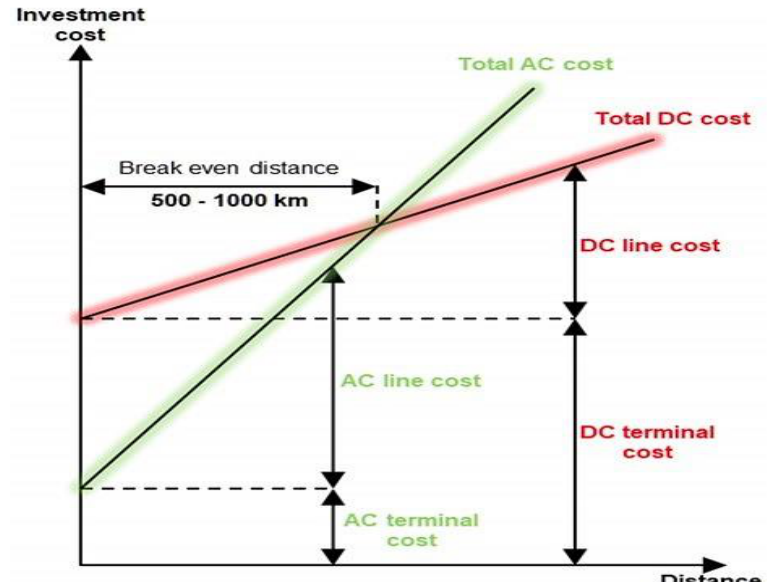
Figure 10. Graphical representation of breakeven distance and compassion of cost and distance of HVDC and HVAC transmission network.